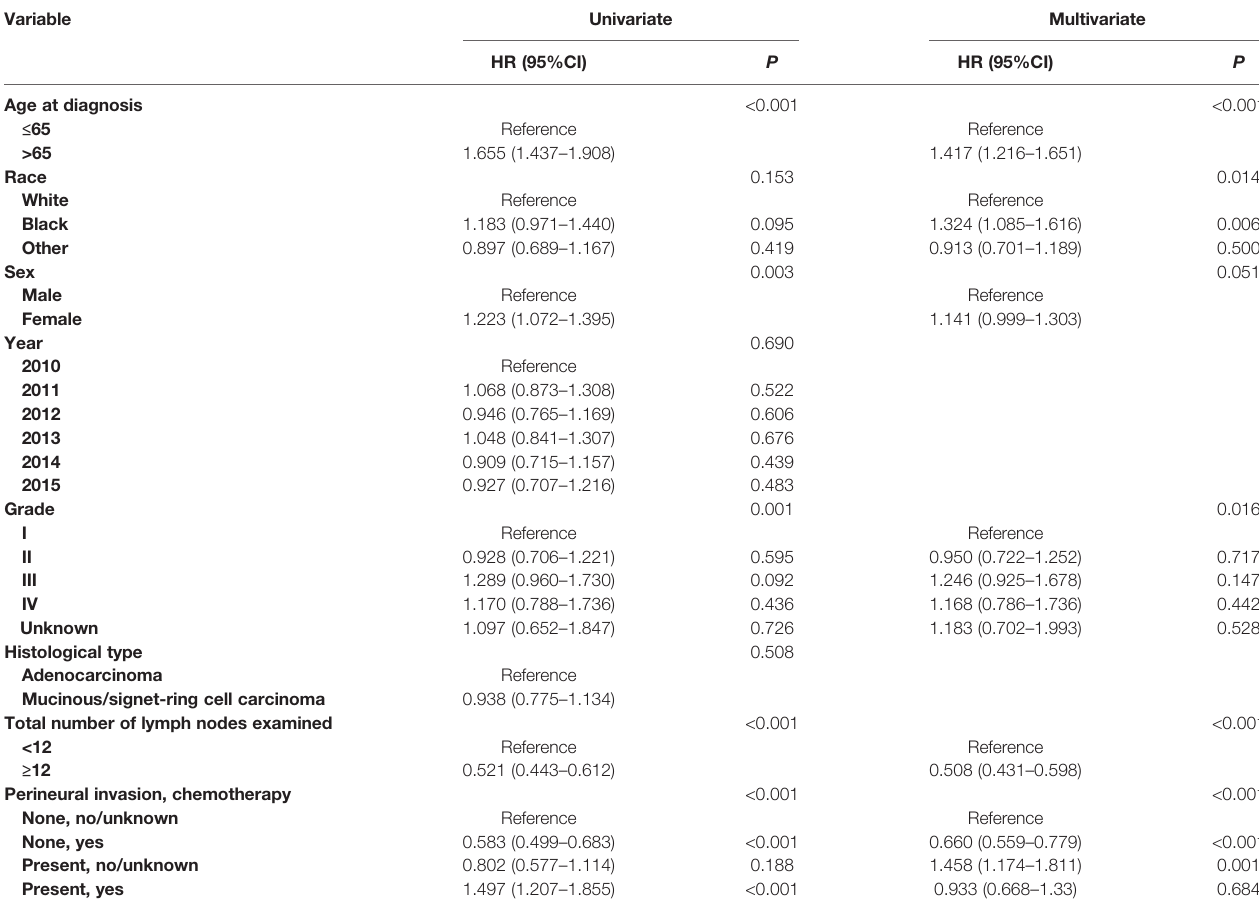
TABLE 5 | Univariate and multivariate survival analyses of T4N0M0 colon cancer.